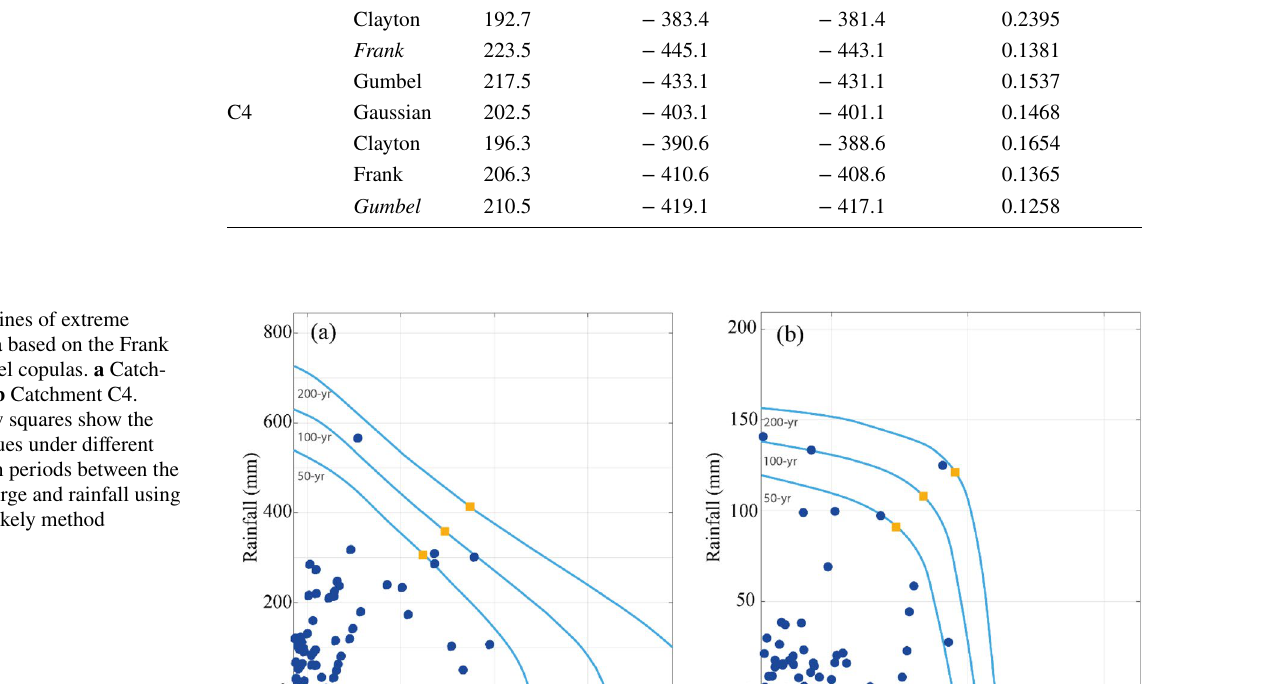
Table 1 Performance measures of the estimated copula functions